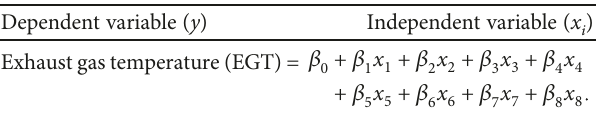
Table 5: Investigational model for the regression analysis. Dependent variable ( y ) Independent variable ( x